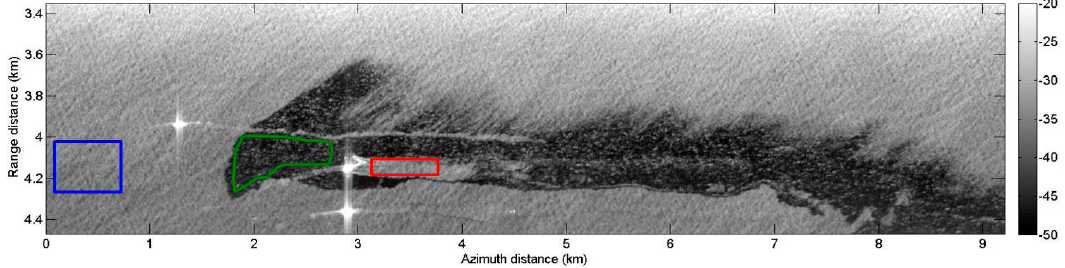
( a ) SETHI X-band SAR image VV-pol and selected areas for histograms computation—slick-free area (blue), slick-covered area (green) and oil recovered area (red).